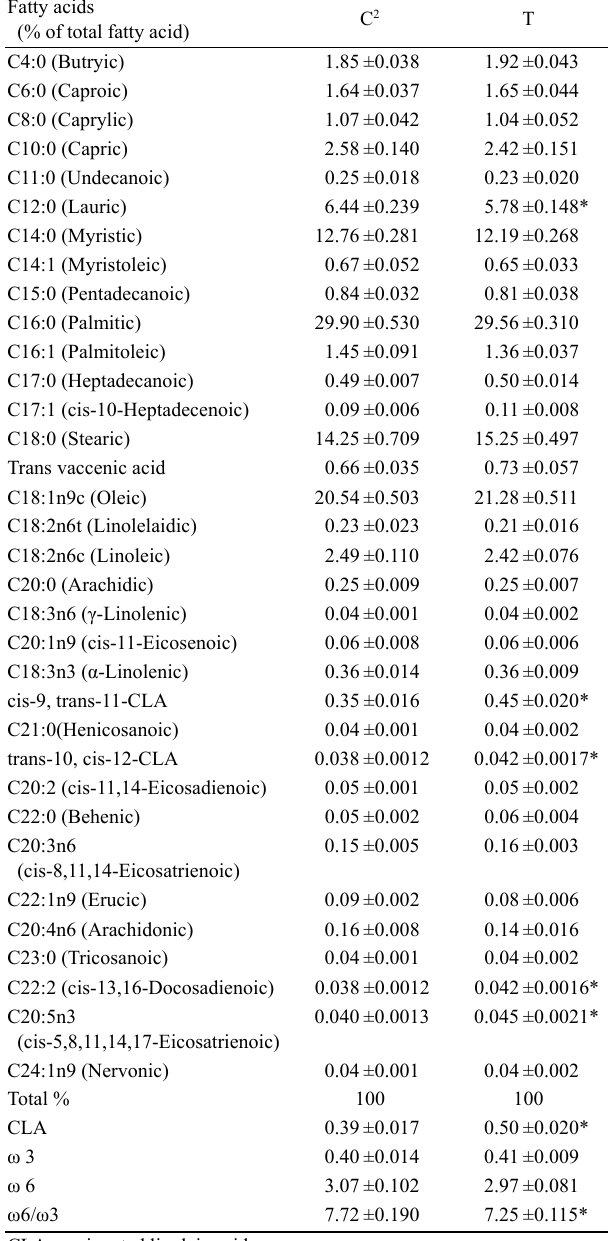
Table 4. Effect of dietary phytoncide on milk composition in dairy cows 1